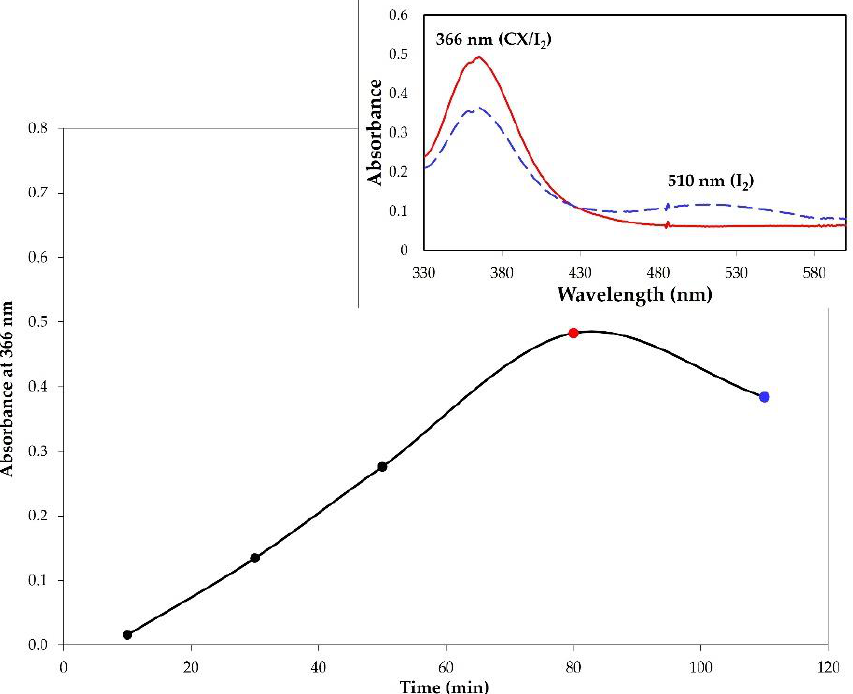
Figure 4. Monitoring of the CX/iodine complex formation by solid–air method. The graphic reports the absorbance values of the complex ( λ = 366 nm) as a function of time. Inset: UV-vis spectrum in chloroform of CX/iodine complex after 80 min (solid red line) and 100 min (dashed blue line).